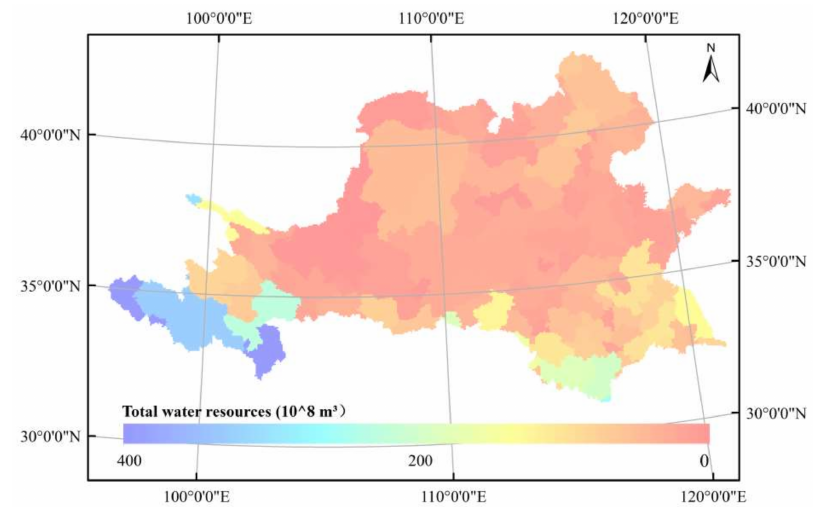
Figure 4. The spatial distribution of the annual average water resources in 128 prefecture-level cities in the Huang-Huai-Hai River Basin from 1951 to